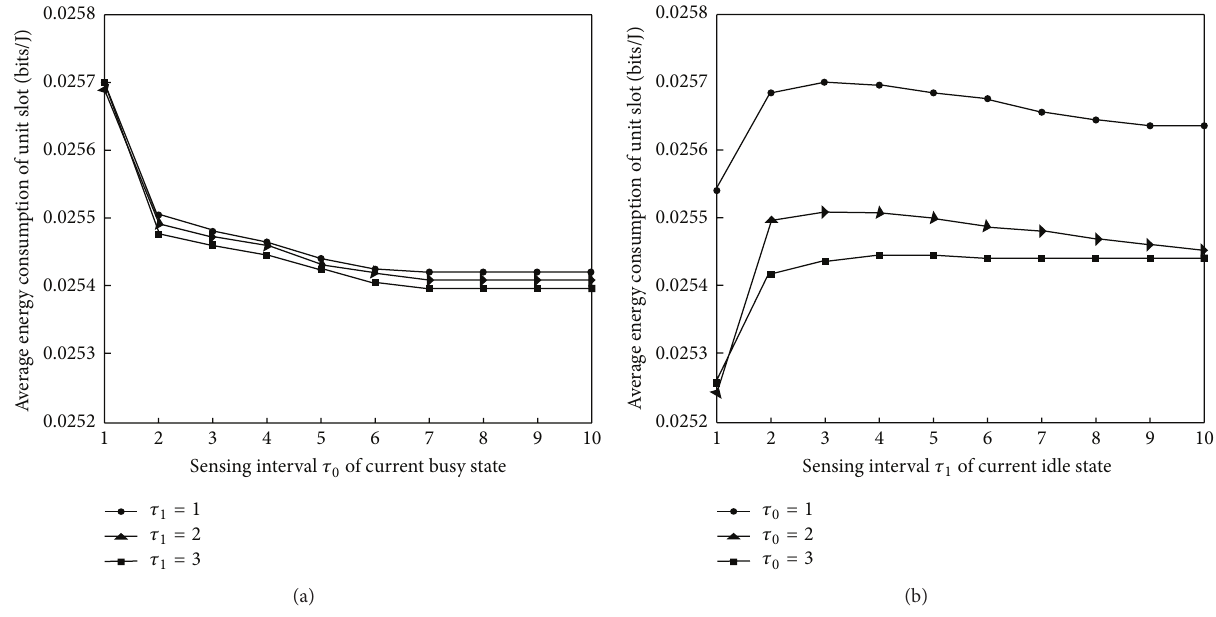
Figure 3: Average energy consumption of different time interval in a unit slot.